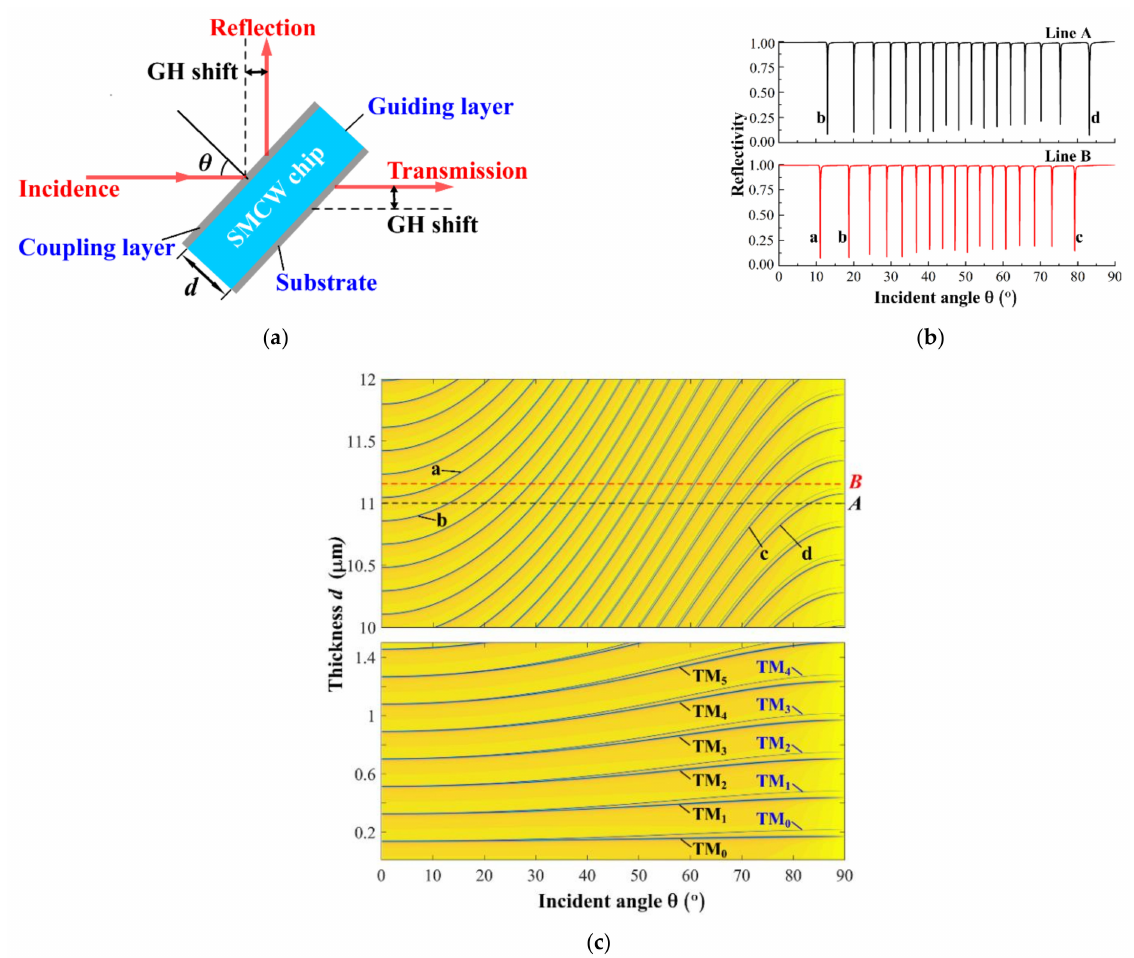
Figure 1. ( a ) The Goos-Hänchen shift of a light wave scattered by the SMCW structure. ( b ) The typical reflection spectra of TM mode of the SMCW with a guiding layer thickness of 11 µ m and 11.15 µ m, respectively. Other parameters are the same as that used in ( c ), and the reflection curves match the dispersion relations at the dashed lines A and B in ( c ). The resonant dips corresponding to four specific mode lines (a, b, c and d) are also marked out. ( c ) The dispersion relation of the SMCW structure, where the number of the accommodated UOMs increases for thick